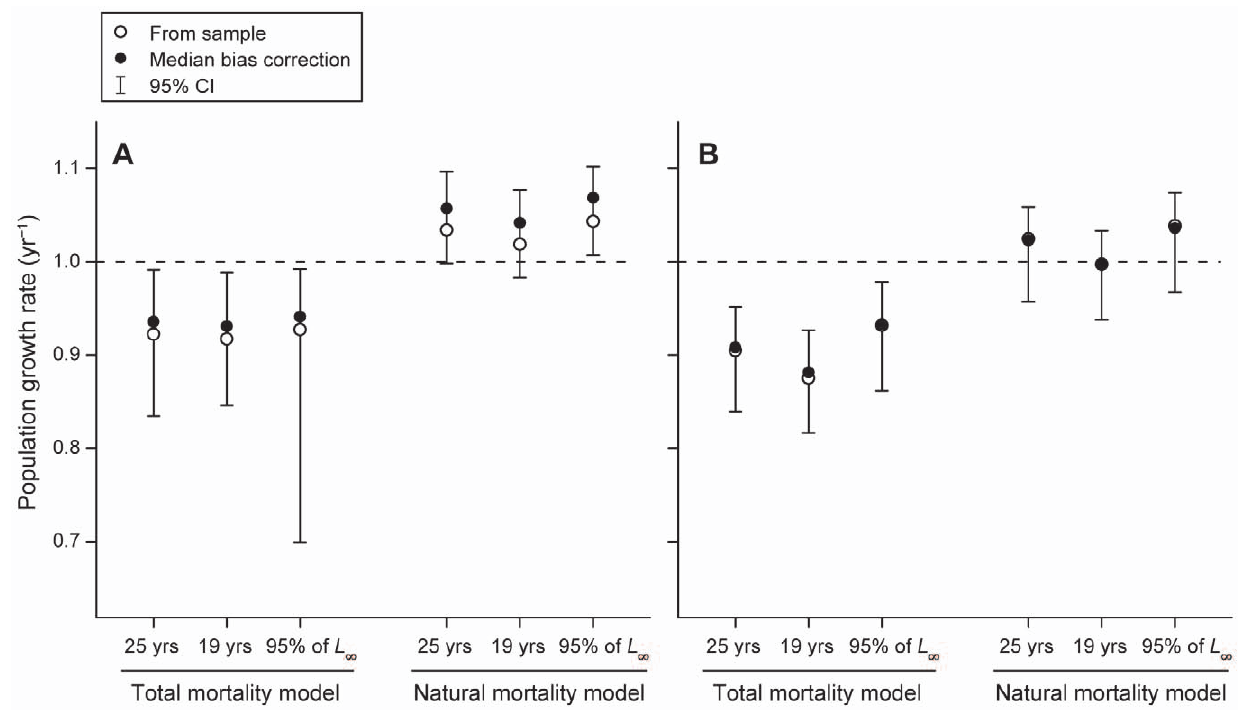
Figure 4. Estimates of consensus natural and total population growth rate for two reef shark species. Estimates were obtained with models with longevity set to 25 years, 19 years and time to achieve 95% of L ‘ (sample estimate: 52 and 50 years, respectively) for (A) T. obesus and (B) C. amblyrhynchos on the Great Barrier Reef. For each method, an open circle indicates the (raw) sample estimate, which was obtained using maximum likelihood parameter estimates from analysis of the empirical data, a closed circle indicates the bootstrap bias-corrected estimate, and whiskers indicate 95% bias-corrected, accelerated (BCa) bootstrap confidence intervals. Dashed lines indicate the threshold between population growth (above) and decline (below).